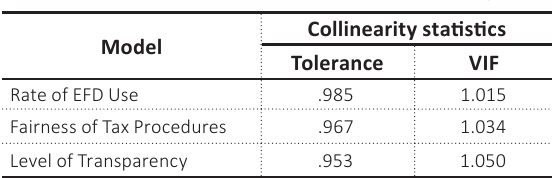
Table 1. Multicollinearity coefficients of equation